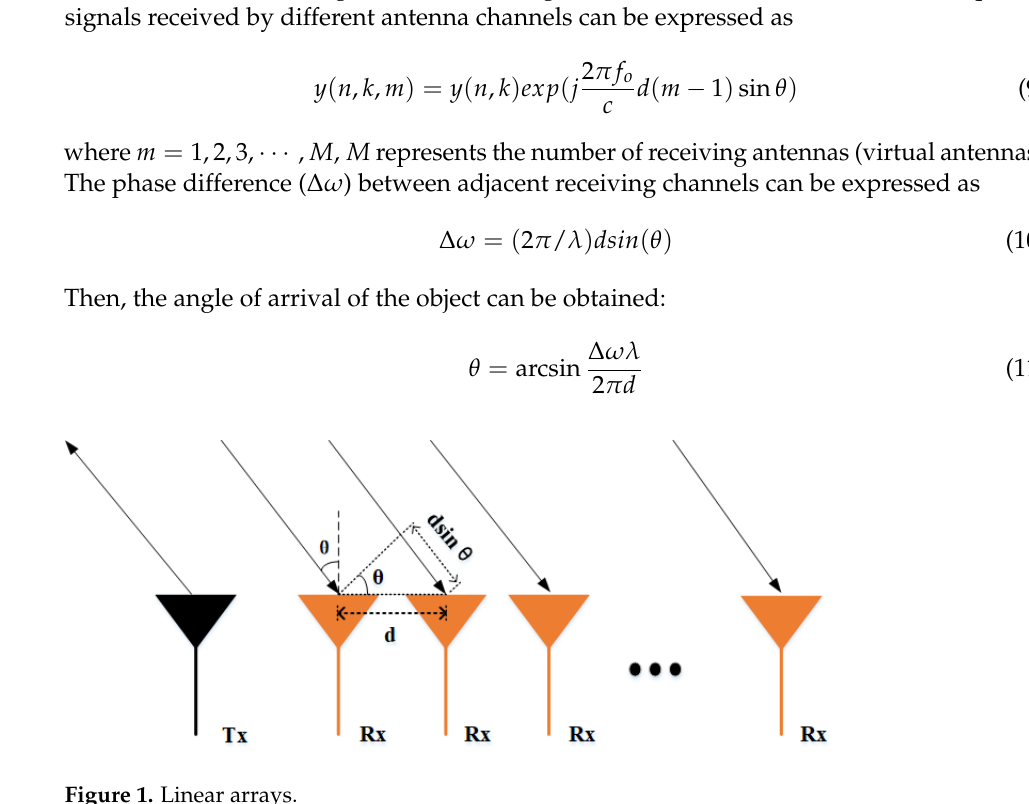
Figure 1. Linear arrays.